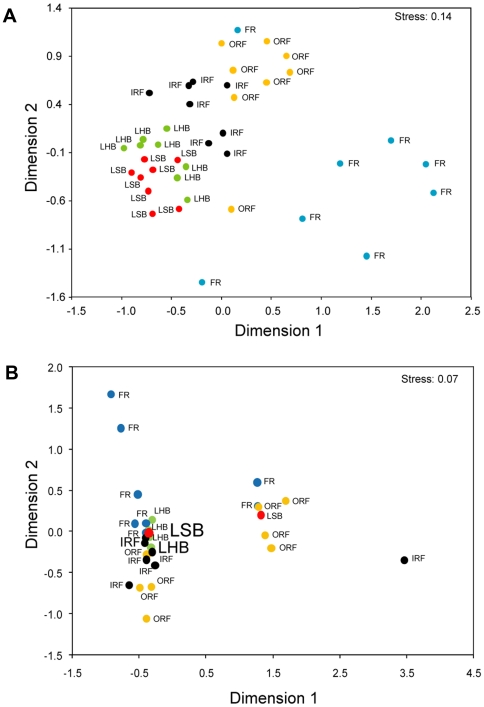
Multidimensional Scaling (MDS) analysis of fish assemblage structure.MDS plot of: A) fish species diversity; and B) fish biomass at each sampling location for each of the five habitat types. Habitat types are abbreviated as in Figure 3. Note that in B) many locations overlap. A larger number of overlapping points is indicated by an increasingly larger font size.